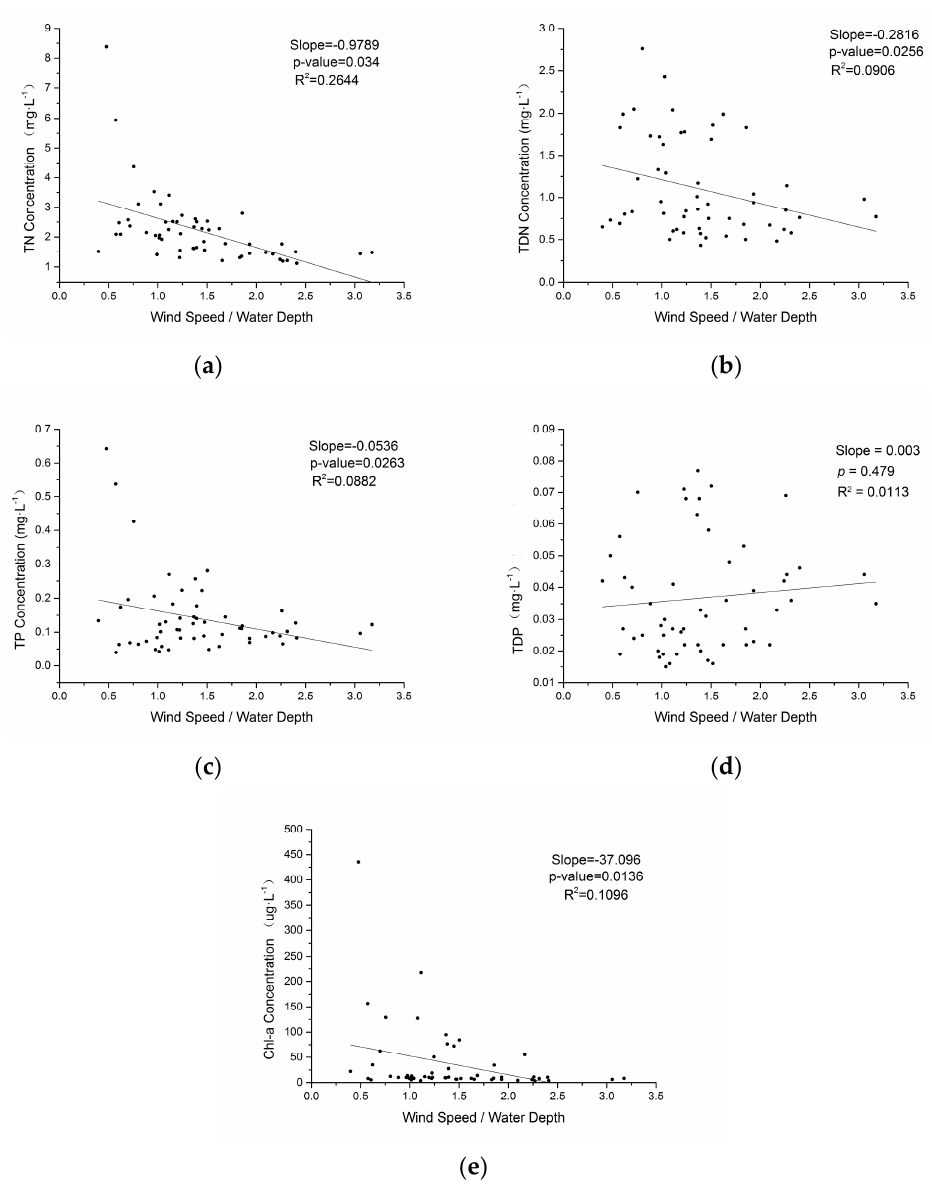
Figure 13. Plots showing vertical shear stress (as measured by the ratio of wind speed to water depth) versus concentrations of: ( a ) total nitrogen(TN); ( b ) total dissolved nitrogen(TDN); ( c ) total phosphorus (TP); ( d ) total dissolved phosphorus (TDP); and ( e ) chlorophyll-a (Chl-a), in Meiliang Bay (see Figure 1).